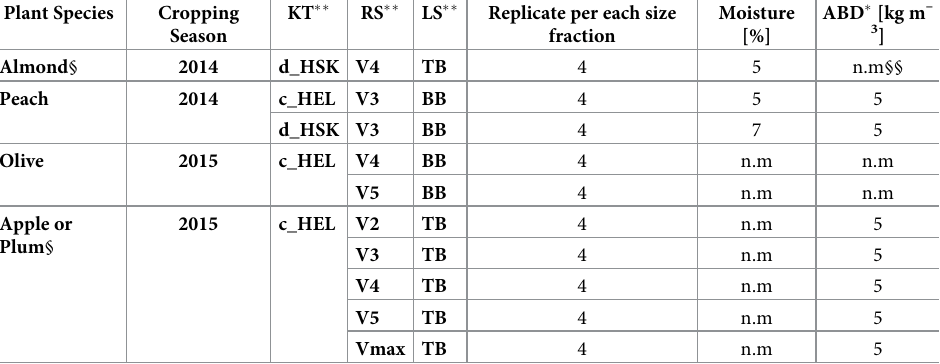
Table 3. Variables related to the product quality, number of replicate per treatment: Knife type [KT], Rotation speed [RS], and Loading system